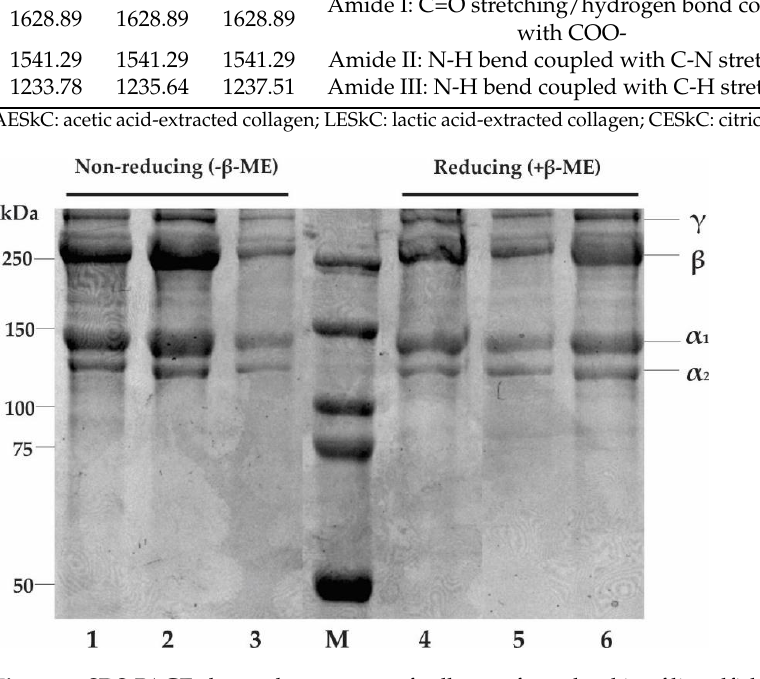
Figure 3. SDS-PAGE electrophoretogram of collagens from the skin of lizardfish shows the occur- rence of band pattern of α, β , and γ isomers . Lane 1 and 4: acetic acid-extracted collagen (AESkC); lane 2 and 5: lactic acid-extracted collagen (LESkC); lane 3 and 6: citric acid-extracted collagen (CESkC); M: protein